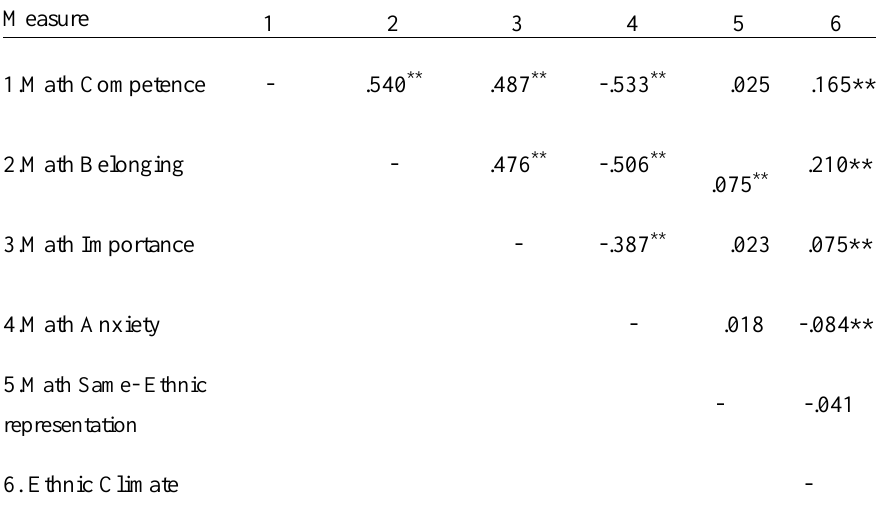
Hierarchical Linear Regression Analysis Mixed-Effects Hierarchical Linear Modeling REML (Restricted Maximum Likelihood) was used to examine if attitudes toward math varied as a function of math level, perceived same ethnic peers in math class, and ethnic climate. Since the residuals were normally distributed and there was no evidence of heteroscedasticity, all assumptions for hierarchical regression were met. Our analysis also allowed for the handling of complex error structures that could result from the nesting of high schools in our study (Stata, 2005). Intercepts were treated as random and slopes were treated as fixed. At Level 1 we included gender (boys as the reference group) and ethnicity (Whites as the reference group) as covariates and at Level 2 we added high school ethnic diversity as a third covariate. Thus, the main analyses reported controlled for gender, ethnicity, and school level